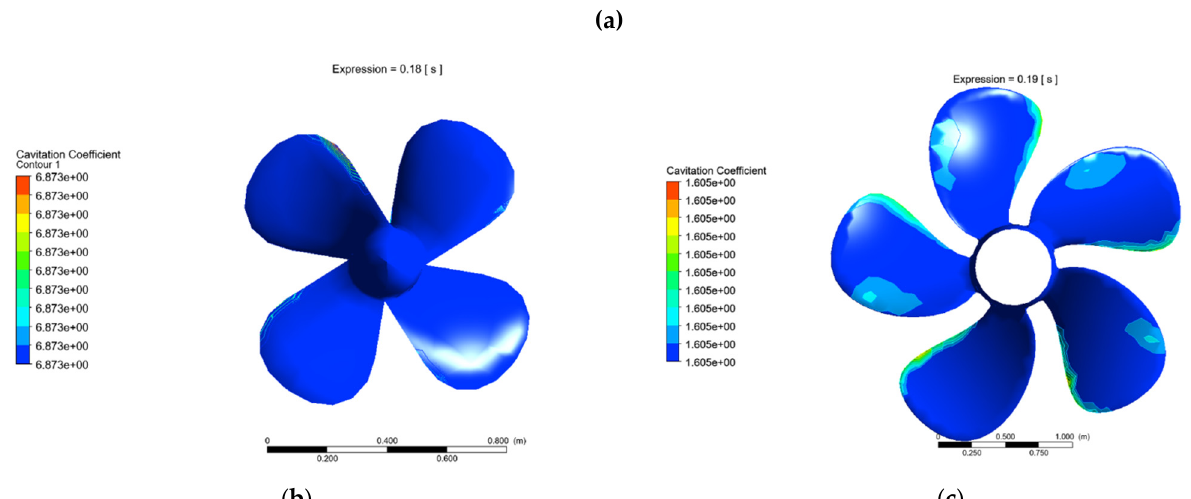
Figure 6. The contour visualized the cavitation patterns at 0.19 s for: ( a ) three blades, ( b ) four blades, and ( c ) five blades.